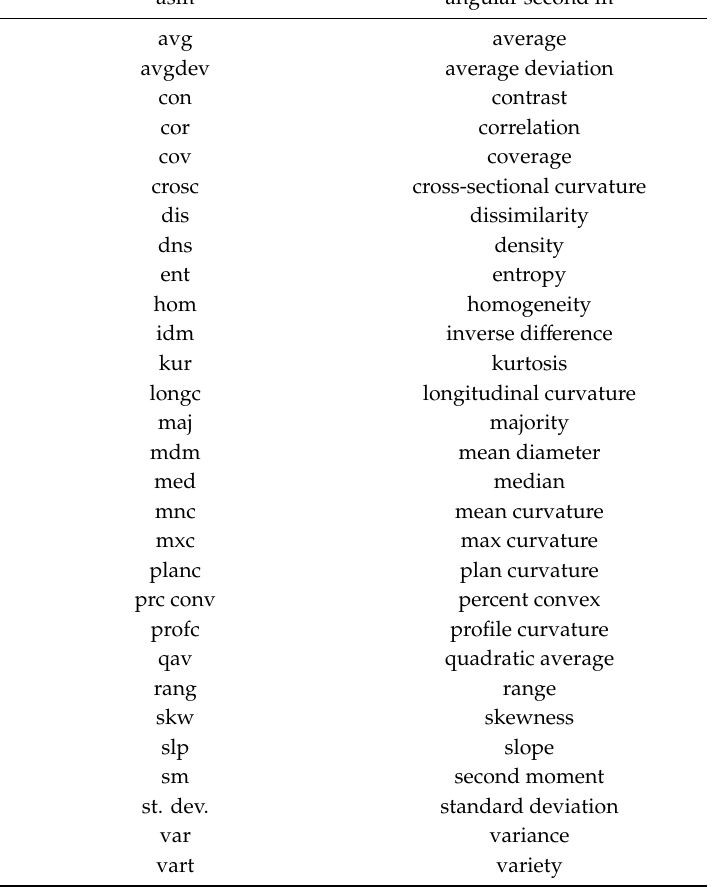
2 Abbreviations for Tables A1 and